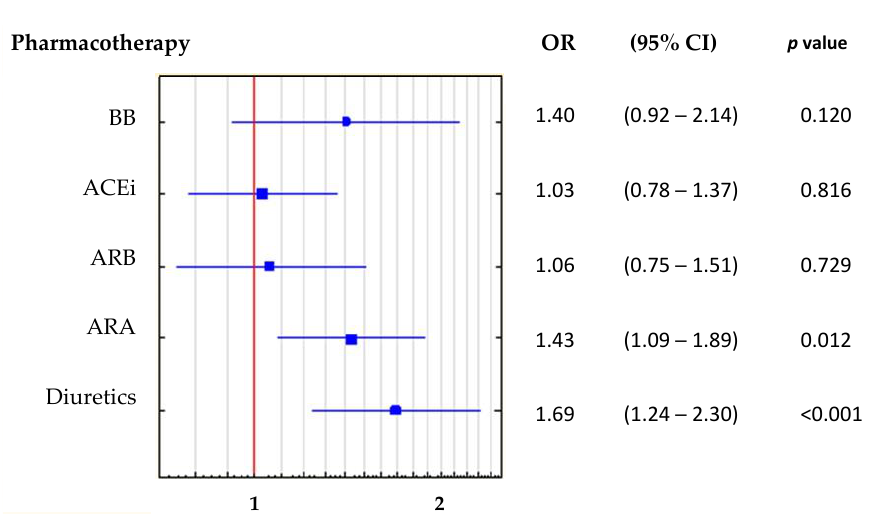
Figure 7. Results of univariate logistic regression for all groups of drugs. Abbreviations: BB, beta- blockers; ACEi, angiotensin converting enzyme inhibitors; ARB, angiotensin receptor blockers; ARA, aldosterone receptor antagonists; OR, odds ratio; CI, confidence interval. Diuretics: any and all diuretics, including ARA or/and loop diuretics.